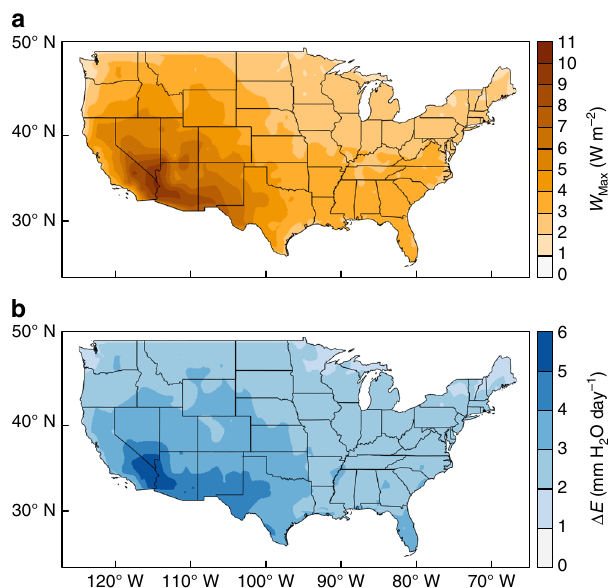
Fig. 3 Maps of power generation from natural evaporation and water savings. a Maximum power density available and b total decrease in evaporation rate due to power harvesting potentially available from open water surfaces across the contiguous United States of America. Maps calculated using the data 22 across 934 weather stations to calculate W Max and corresponding Δ E at each location from eq. (3) with natural neighbor interpolation and linear extrapolation to generate a 5 ′ resolution wind and photovoltaic installations are 2.90 and 8.06 W m